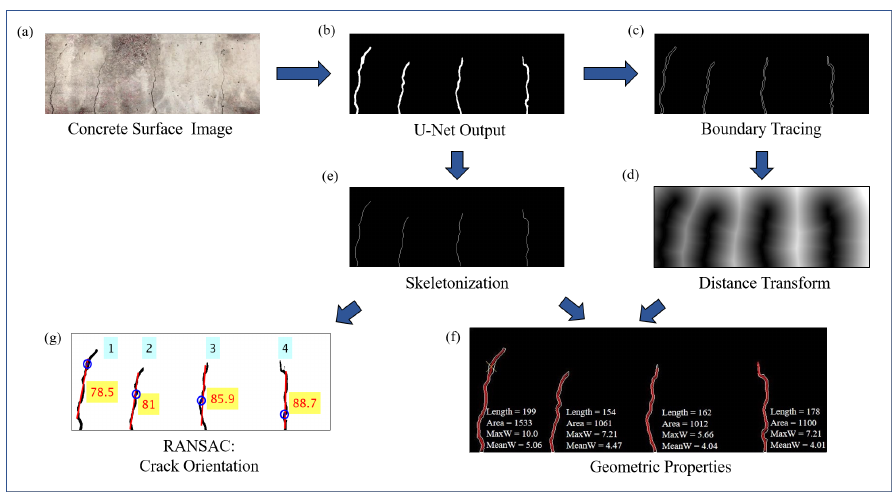
Figure 5. Flowchart of algorithms applied on input concrete surface image to obtain geometric properties of